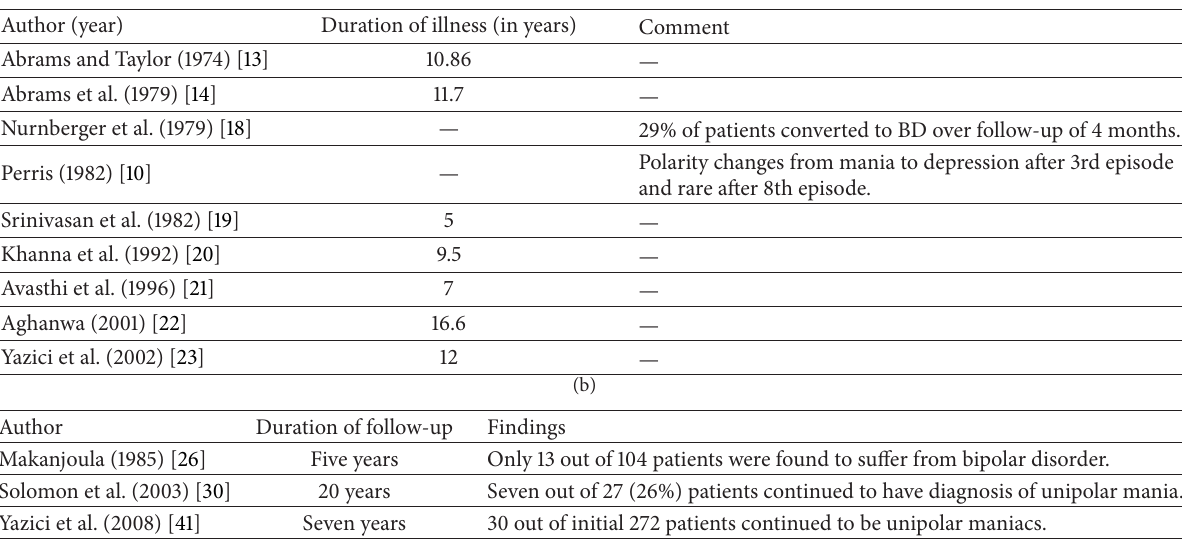
Table 3: (a) Retrospective chart review-based studies assessing the course of UM. (b) Diagnostic stability of UM in prospective